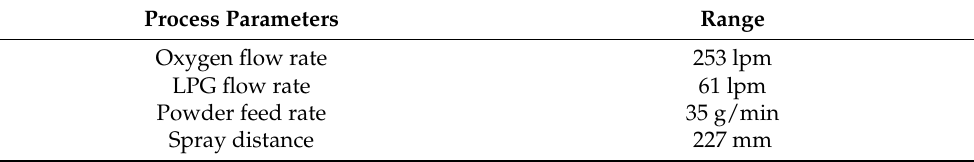
Table 1. HVOF process parameters.